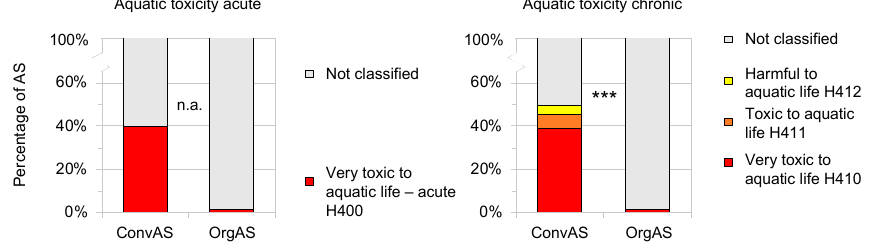
Figure 7. Comparison of acute and chronic aquatic toxicity of active substances (AS) approved for use in conventional (ConvAS, n = 256) and organic agriculture (OrgAS, n = 134). Results of chi 2 tests denoted with asterisks: *** p < 0.001; n.a. … a chi 2 test was not applicable because of too few catego- ries.